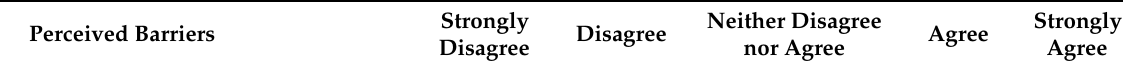
Table A4. Perceived Barriers and Facilitators to Use Electronic